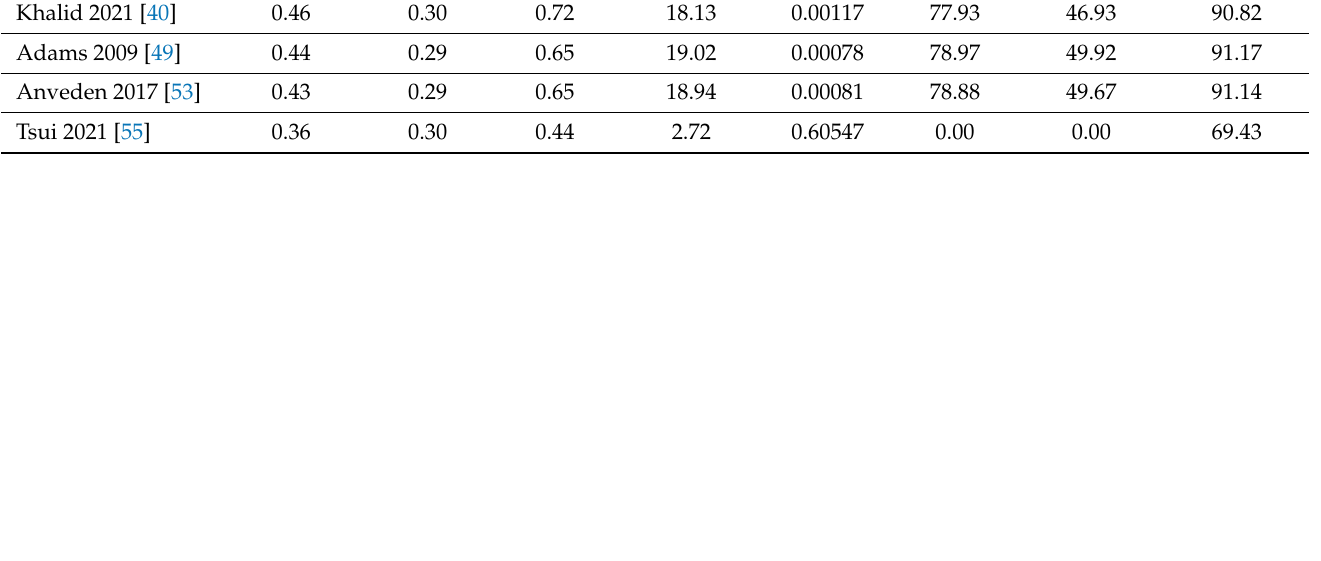
Figure A9. Colorectal cancer random e ff ects model funnel plot.